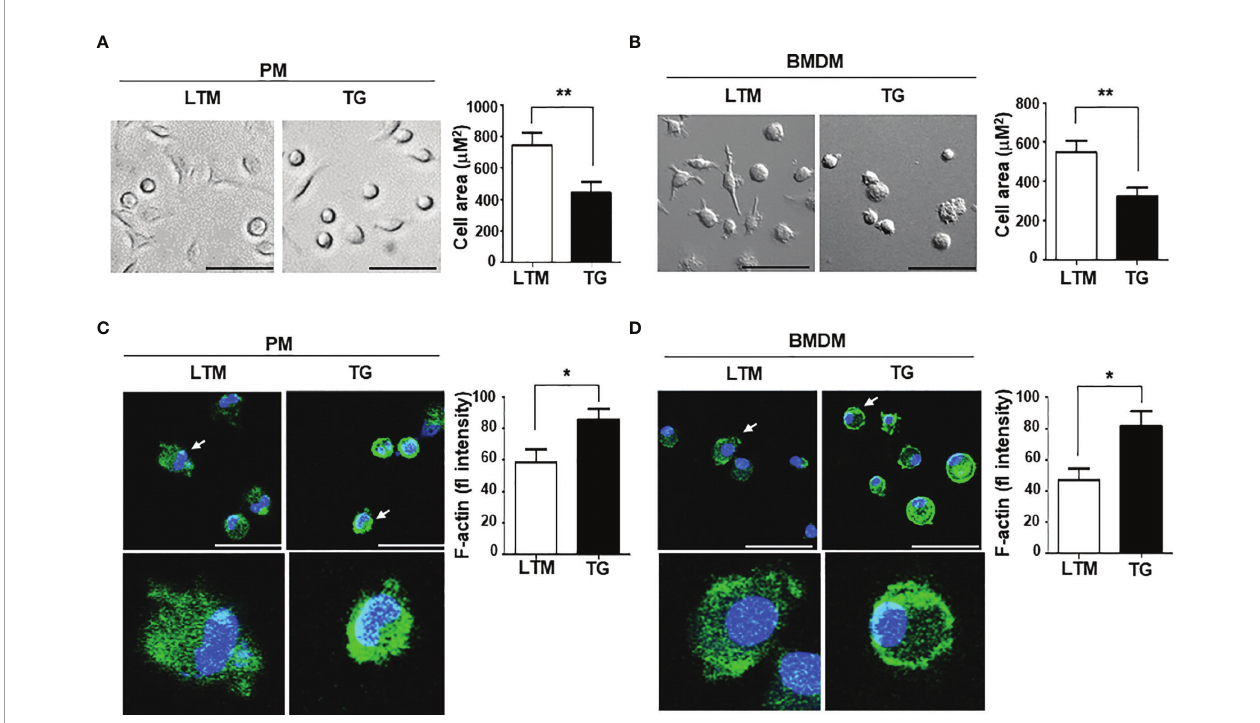
FIGURE 2 | Morphological characteristics associated with p190RhoGEF transgene expression in TG macrophages. (A, B) Morphological comparison of PMs and BMDMs from LTM and TG mice. Scale bars = 50 m m. Cellular area was measured in each experiment and the data were compared as the mean ± SEM. Statistical signi fi cance was analyzed by unpaired t tests. Signi fi cant comparisons are noted as ** p < 0.01. (C, D) Actin and nuclei staining with FITC-phalloidin (green) and DAPI (blue), respectively, in PMs and BMDMs from LTM and TG mice. All are merged images of actin staining and DAPI. Scale bars = 50 m m. An enlarged image of single cell (indicated by an arrow) is also shown. Green fl uorescence ( fl ) intensities of cells in each experiment were analyzed and the data were compared as the mean ± SEM. Statistical signi fi cance was analyzed by unpaired t tests. Signi fi cant comparisons are noted as * p < 0.05. All data are representative of fi ve separate